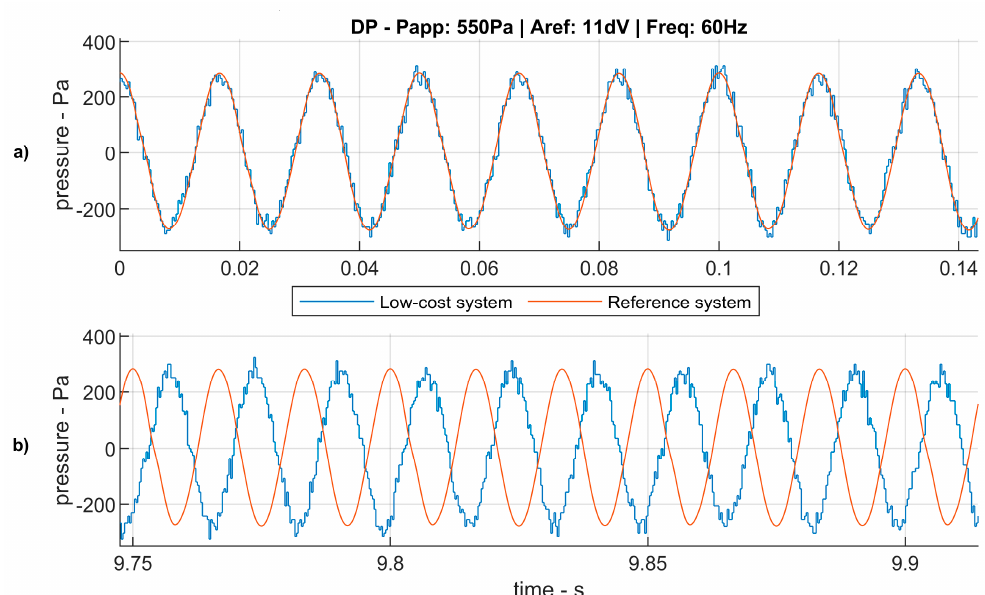
Figure 8. Detail of the time discrepancy between the low-cost and the high-fidelity acquisition systems. Both subfigures show the same signal at different time intervals. ( a ): Initial time interval of the signal. ( b ): Final time interval of the signal. After few seconds, the frequency discrepancy between the reference signal and the measure signal become visible.